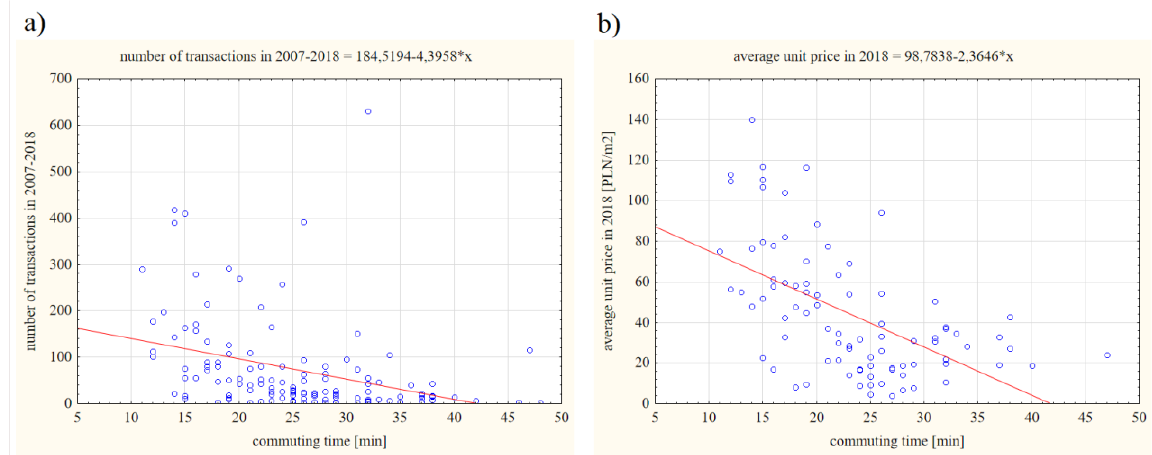
Figure 8. Correlations between ( a ) commuting time and the number of transactions, ( b ) commuting time and average unit prices. Source: own